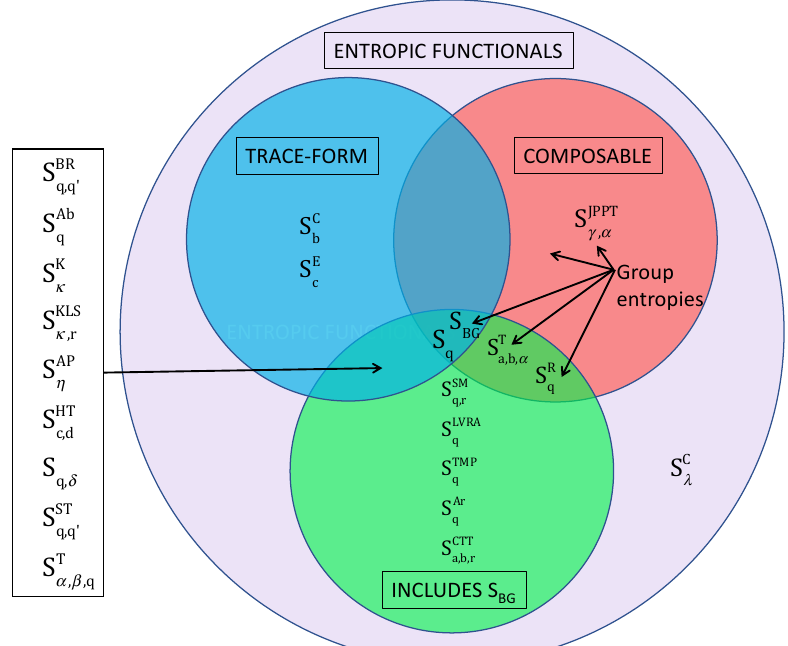
Figure 4. It has been proved [54] that S q is the unique entropic form which simultaneously is trace-form, composable, and recovers S BG as a particular instance. S q (hence S BG ), the Renyi entropy S R q [14], the Tempesta ( a , b , α ) -entropy S T (Equation (9.1) in [57]), the a , b , α